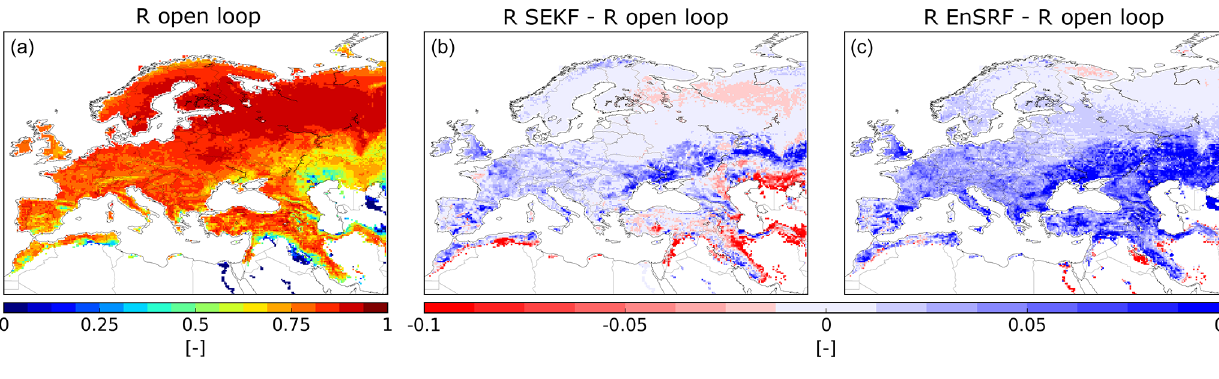
Figure 13. (a) Correlation ( R ) between observed FLUXCOM gross primary production and its open-loop equivalent for the period 2008– 2013 and R difference between assimilation experiments (SEKF in b and EnSRF in c ) and the open